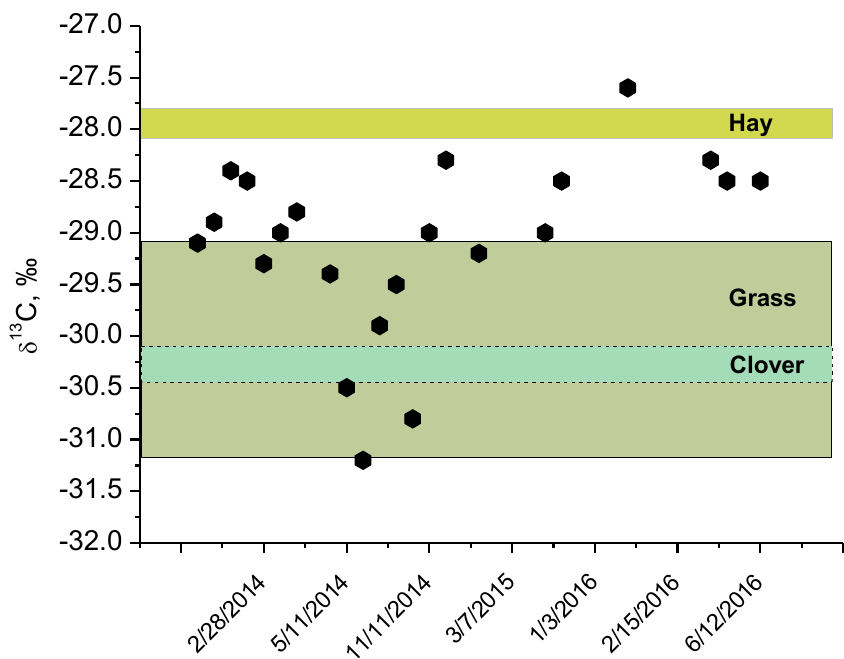
Figure 4. δ 13 C values in the cow milk (dots). The boxes represent the measured δ 13 C values for the hay, grass, and clover. The measured δ 13 C values of clover are overlapping with the δ 13 C values of the grass.